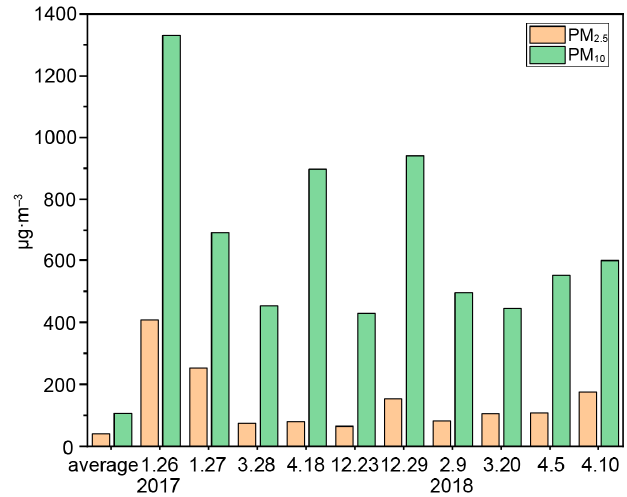
Figure 8. Concentration comparison of PM 2.5 and PM 10 between sandstorms and average.